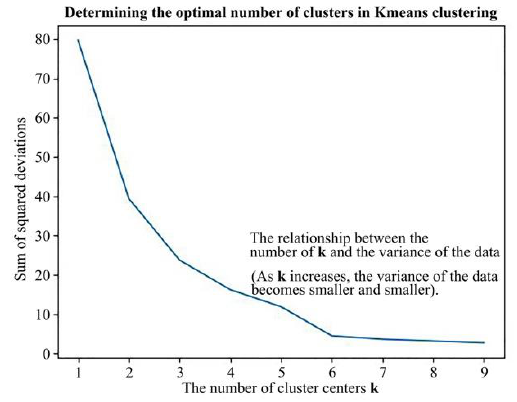
Figure 9. Optimal value of elbow method. Table 3. Analysis of the main driving factors of each group of urban areas. Period